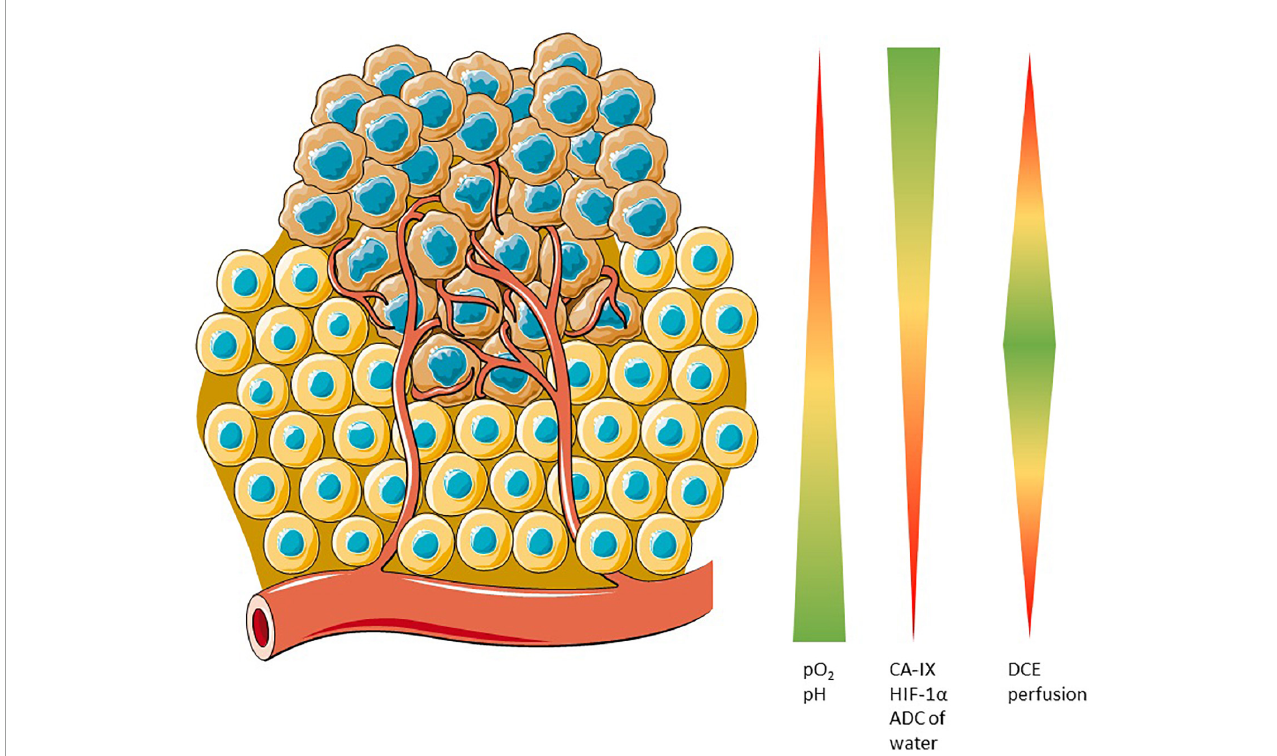
FIGURE1 Potential cellular targets for hypoxia imaging. pO 2 and pH are closely related because of the lack of oxygen leads to an anaerobic metabolism in cell which acidifies the cytoplasm. In hypoxic conditions, CA-IX is overexpressed because of HIF-1 α deregulation. Apparent Diffusion Coefficient is closely related to the pO 2 and Dynamic Contrast Enhanced is sensitive to fine changes in the